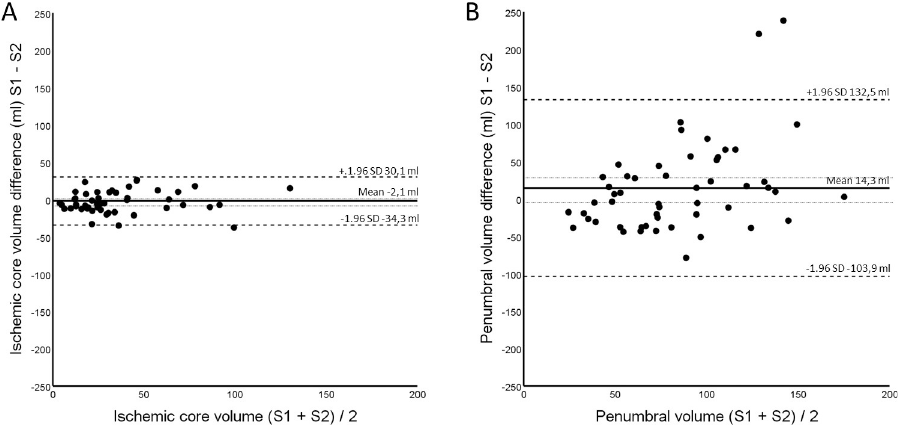
Fig 2. Bland Altman plot visualizing the relationship of the differences of measured volumes between those setting pairs with no significant differences detected using One Sample T tests. A: Measured ischemic core differences between setting 1 (S1) versus setting 2 (S2) using data from both hemispheres. B: Measured penumbral differences using S1 versus S2 with data from both hemispheres. Upper and lower 95% confidence limits for the mean difference in volumes are visualized using thinnest dotted